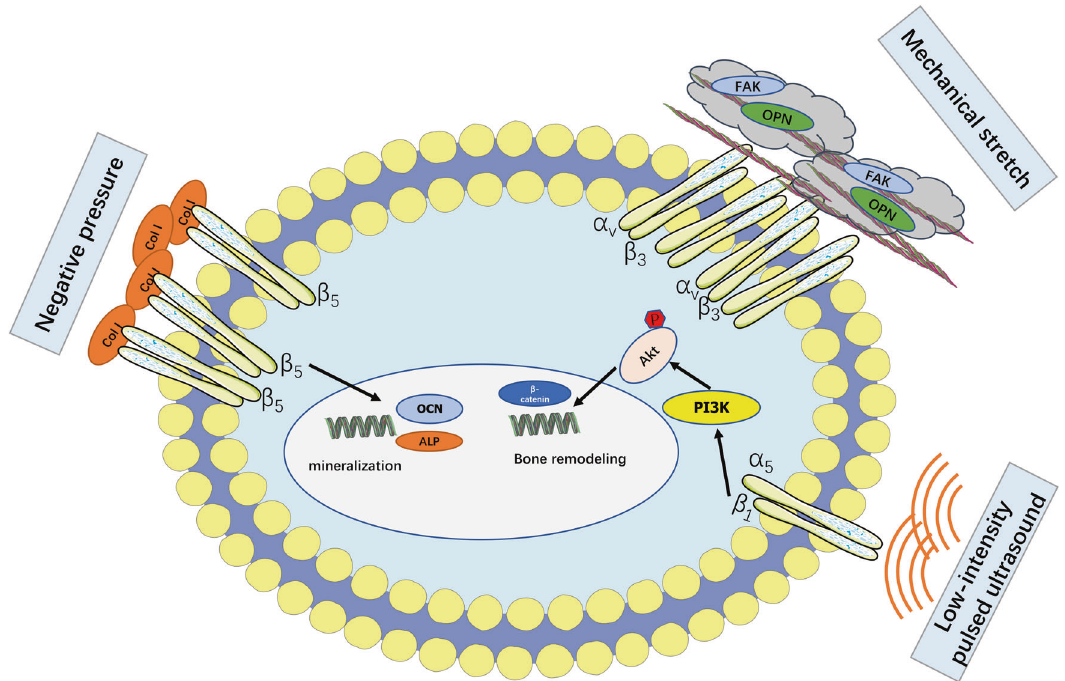
Fig. 5 Integrins mediate physical factors to regulate bone metabolism. Negative pressure therapy enhances the binding of Col I and β 5 integrin to promote cell mineralization. Mechanical stretch promotes the plaque mineralization of integrin α V β 3 -matrix interaction sites. Low- intensity ultrasound enhances bone remodeling by activating integrin α 5 β 1 and promoting Akt phosphorylation.